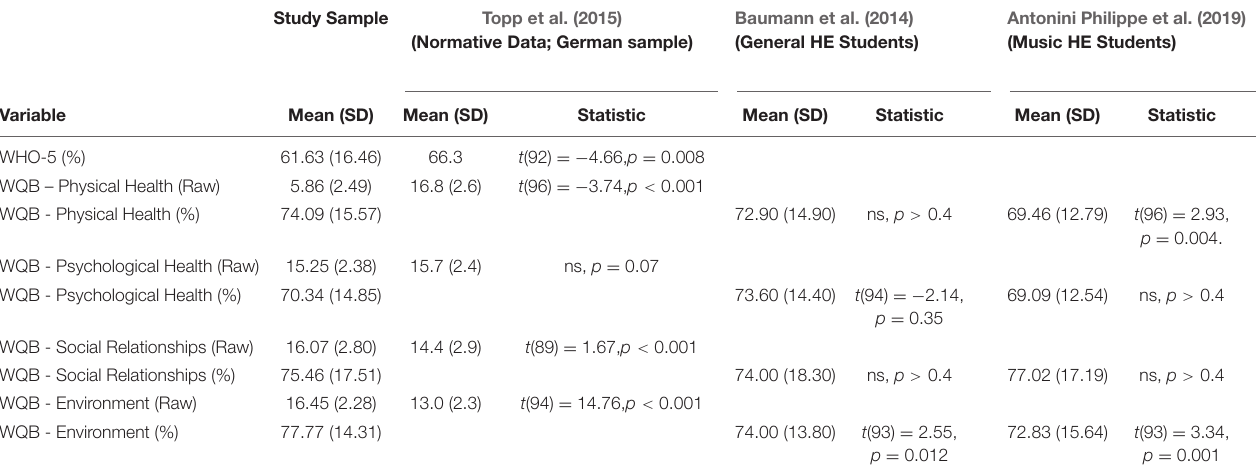
TABLE 2 | Comparison of WHO-5 and WHOQoL-BREF (WQB) wellbeing scores against study sample and comparative data (i.e., published normative, music and other student data). Study